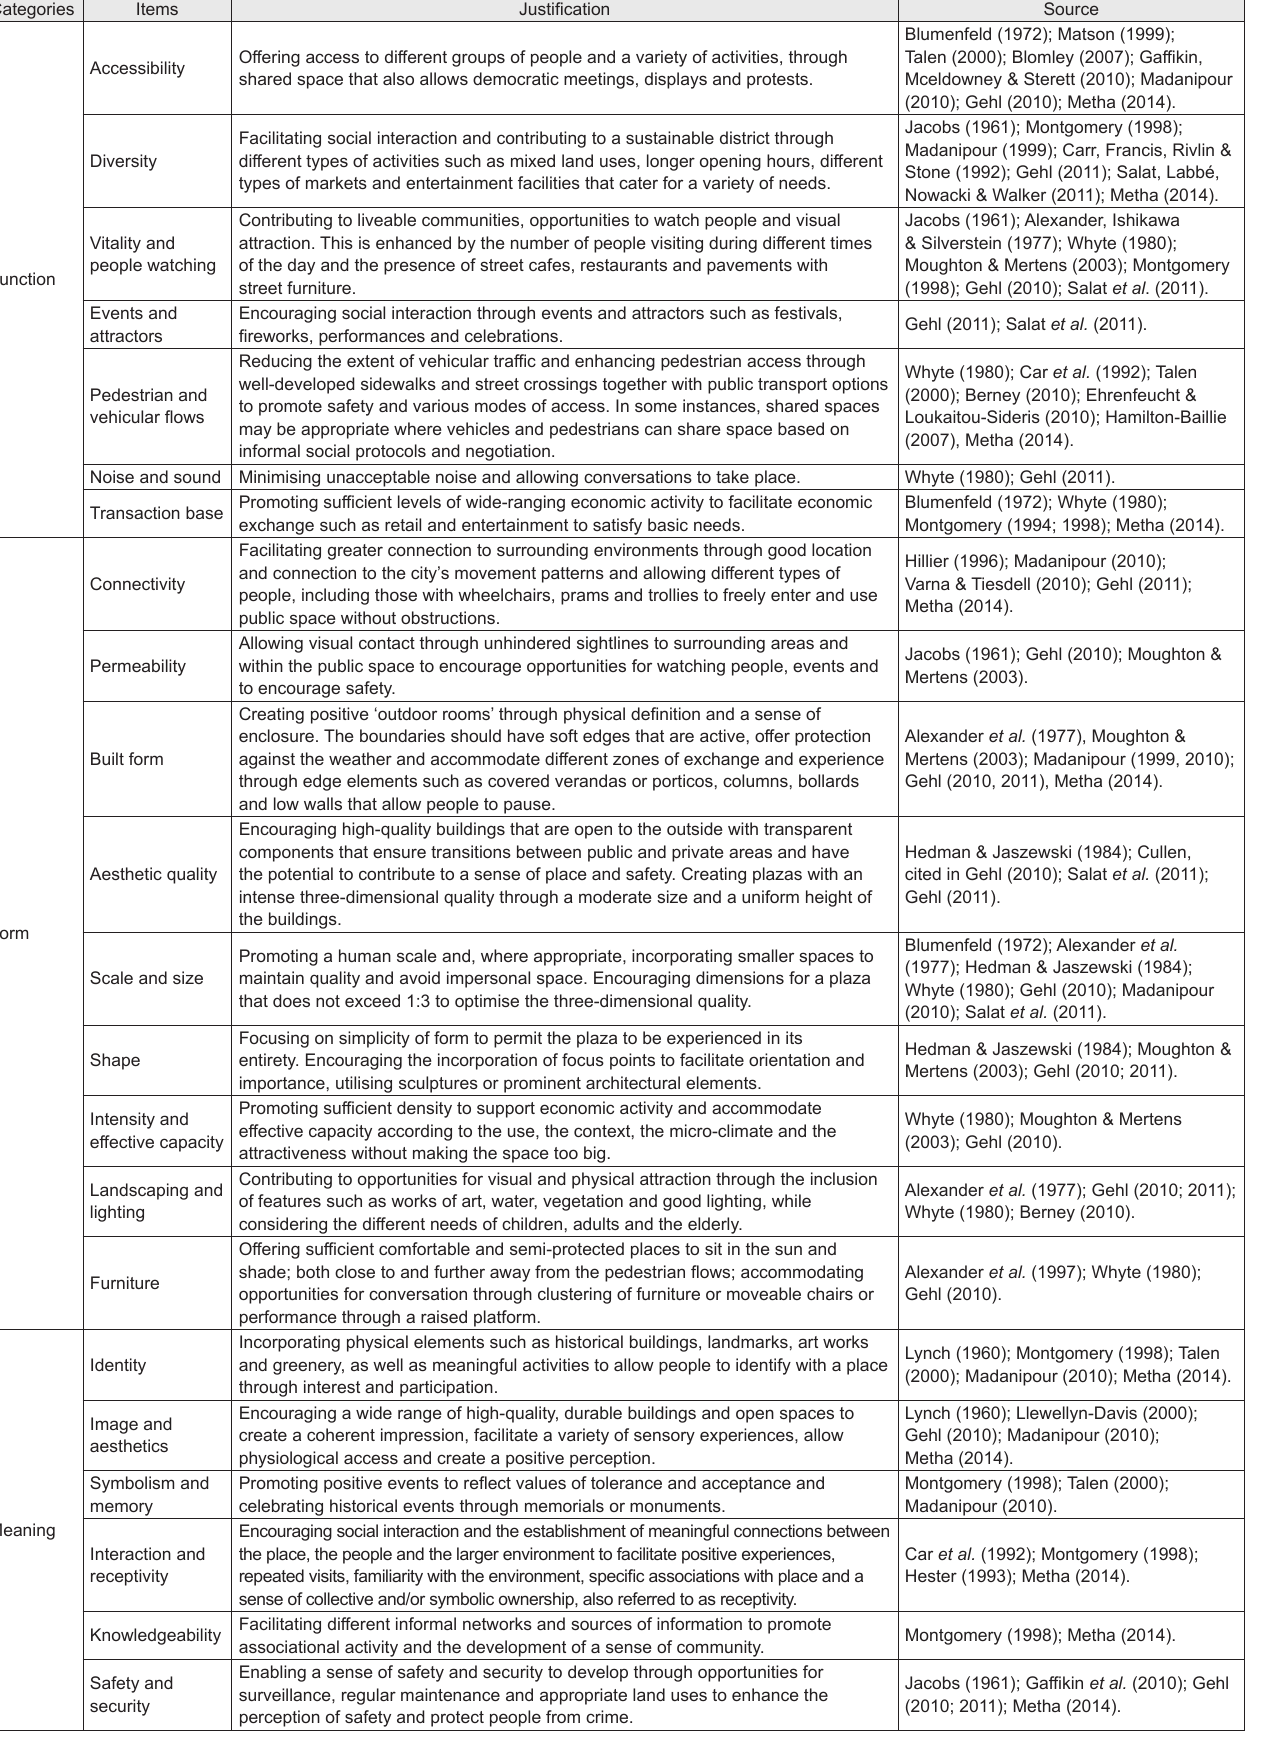
Table 1: Characteristics of successful public